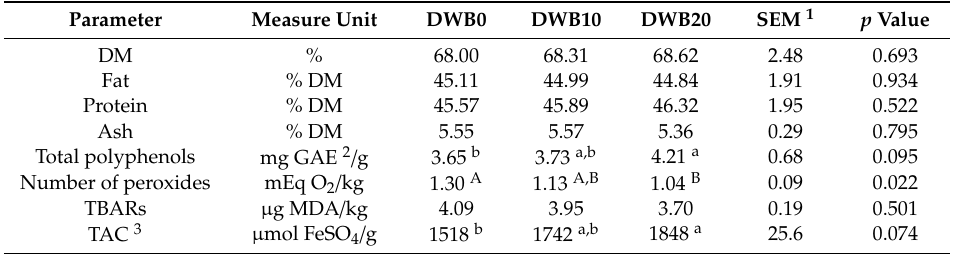
Table 6. E ff ect of feeding regime on cheese composition traits, oxidative products and antioxidant